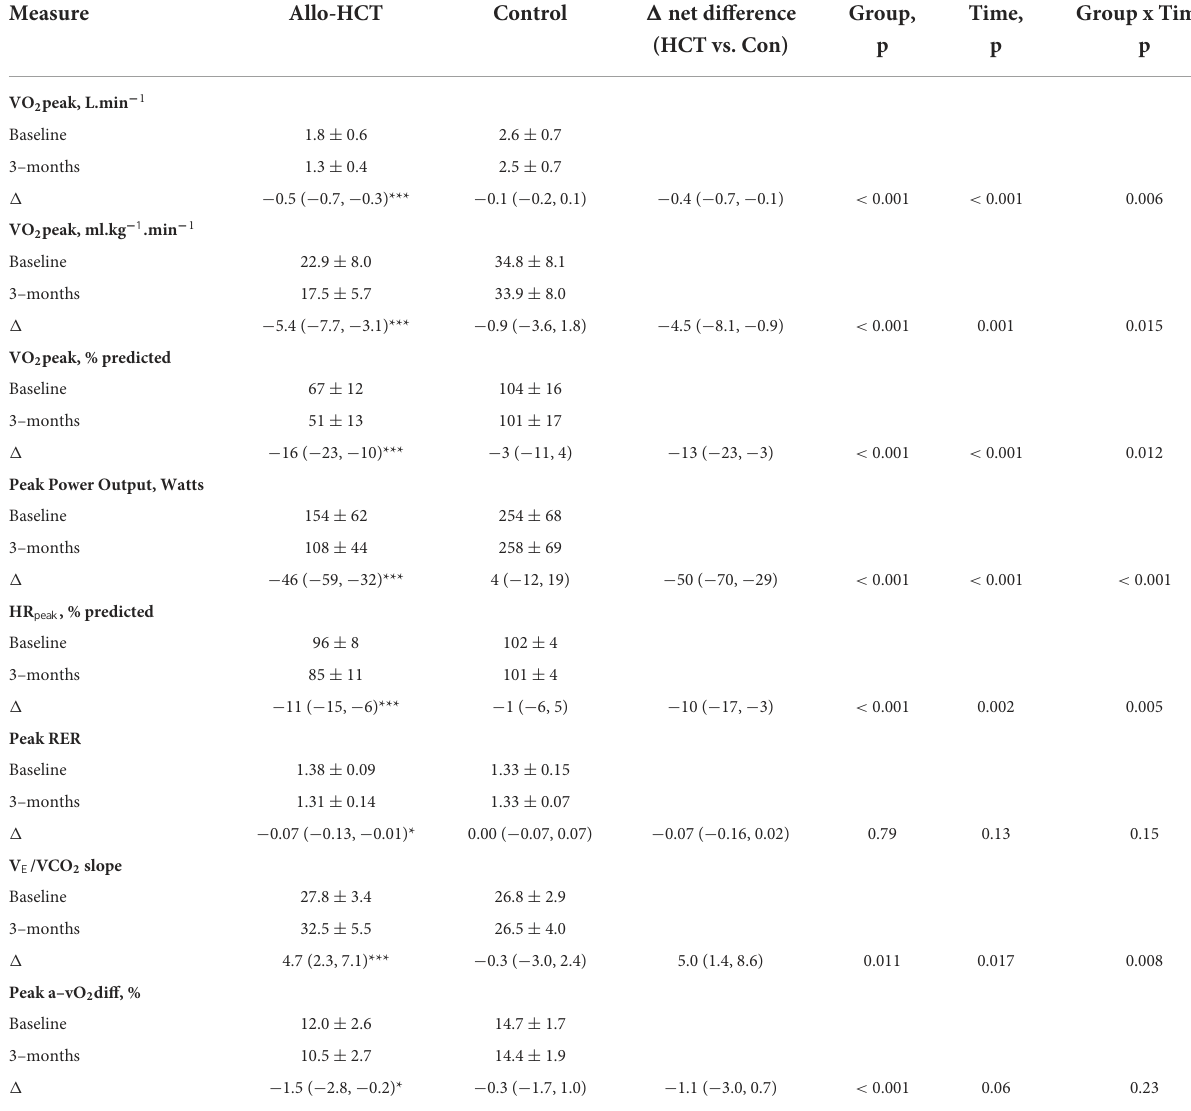
Allbaselineand3–monthvaluesareunadjustedmeans ± SDs;allwithin-groupchangesareunadjustedmean(95%CI)andexpressedasabsolutechangefrombaseline.Meannetdifferences werecalculatedbysubtractingthewithin–groupchangesfrombaselineinthecontrolgroupfromthewithin–groupchangefrombaselineintheallo-HCTgroupafter3months.* p <